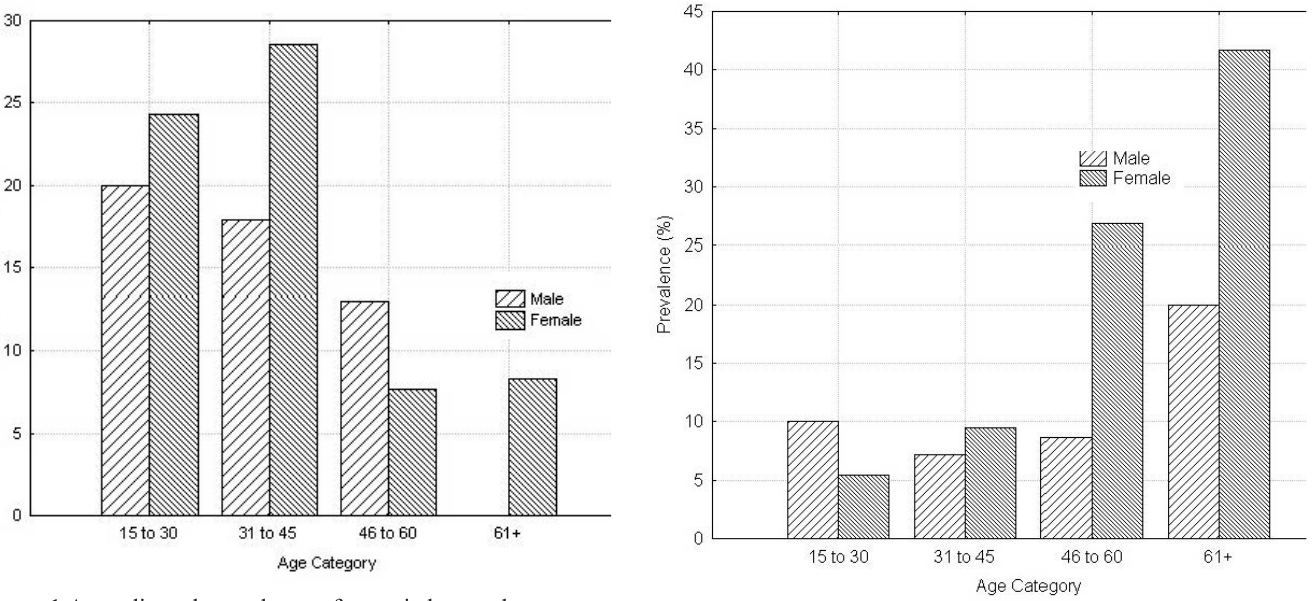
Figure 3 Age adjusted prevalence of hyperopia by